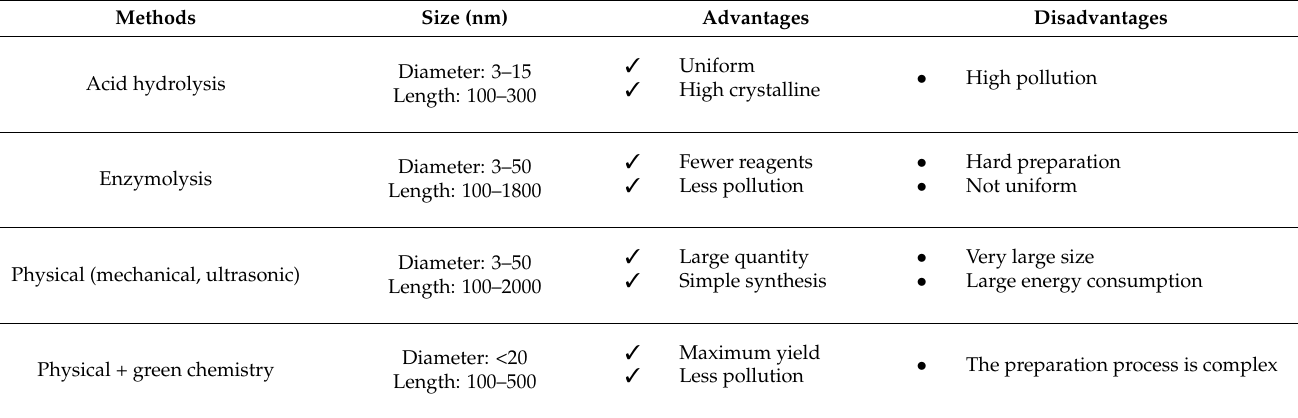
Table 1. Comparison of various pretreatment processes of